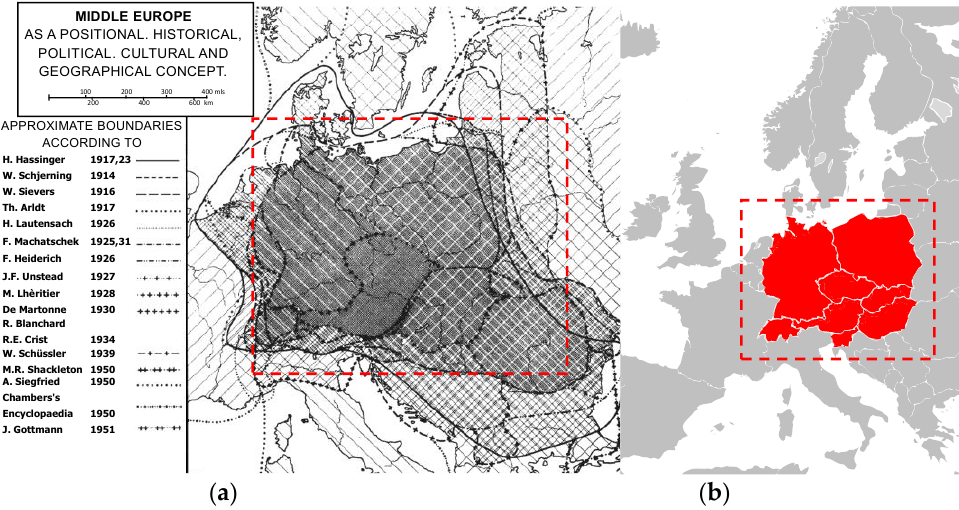
Figure 3. ( a ) Middle Europe as a positional, historical, political, cultural and geographical concept: a graded assessment of the degree of coincidence existing between sixteen definitions of Middle Europe, 1954. Reprinted with permission from [12]. Copyright 1999 – 2022 by the Wiley Online Li- brary. ( b ) Central Europe according to The World Factbook, Encyclopedia Britannica, and Brock- haus Enzyklopädie